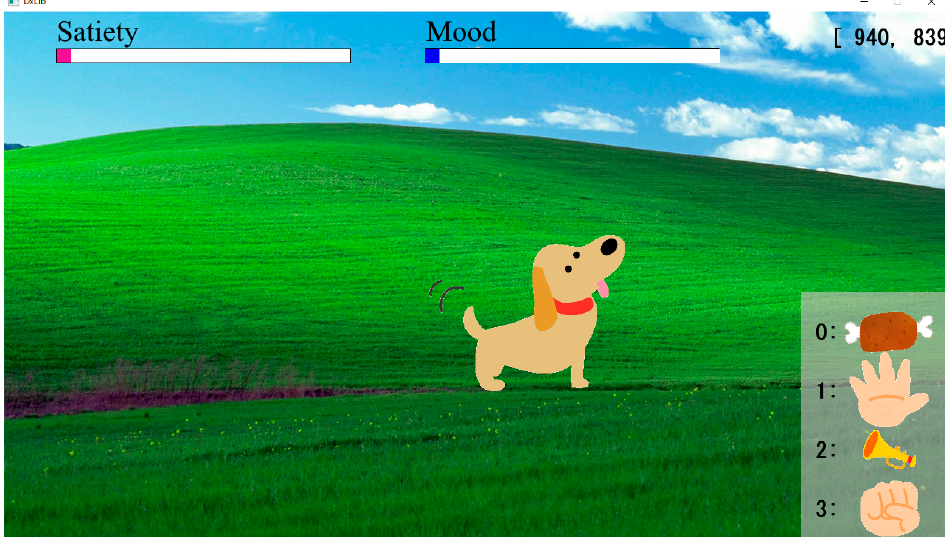
Figure 2. Screenshot exemplifying the “dog-care game”.